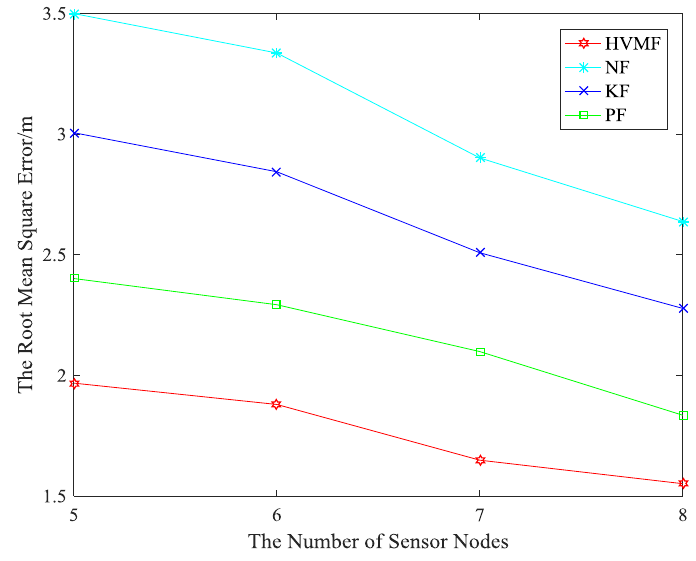
Figure 10. The number of beacon nodes versus Root Mean Square Error (RMSE).